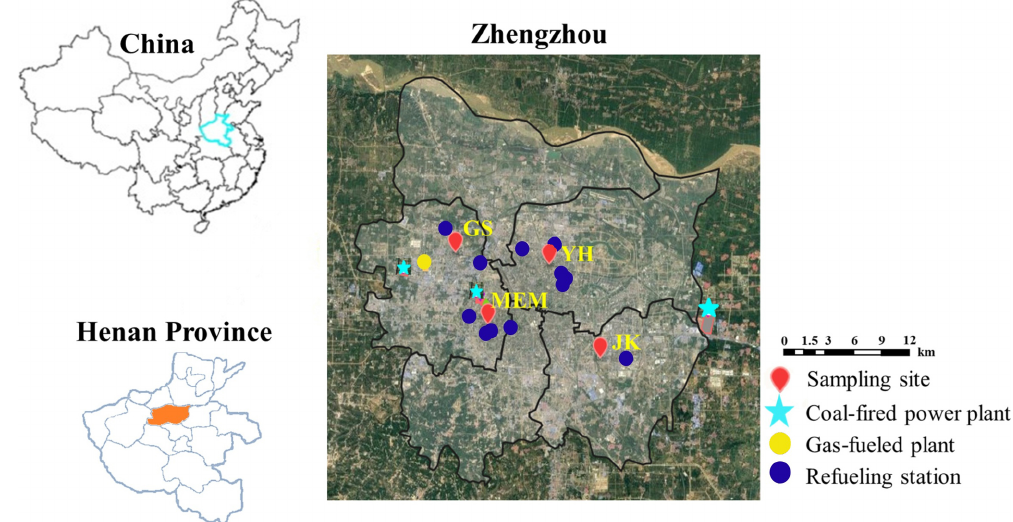
Figure 1. Satellite imagery showing the four sampling sites and surrounding areas of Zhengzhou, China, including major emission sources shown by different